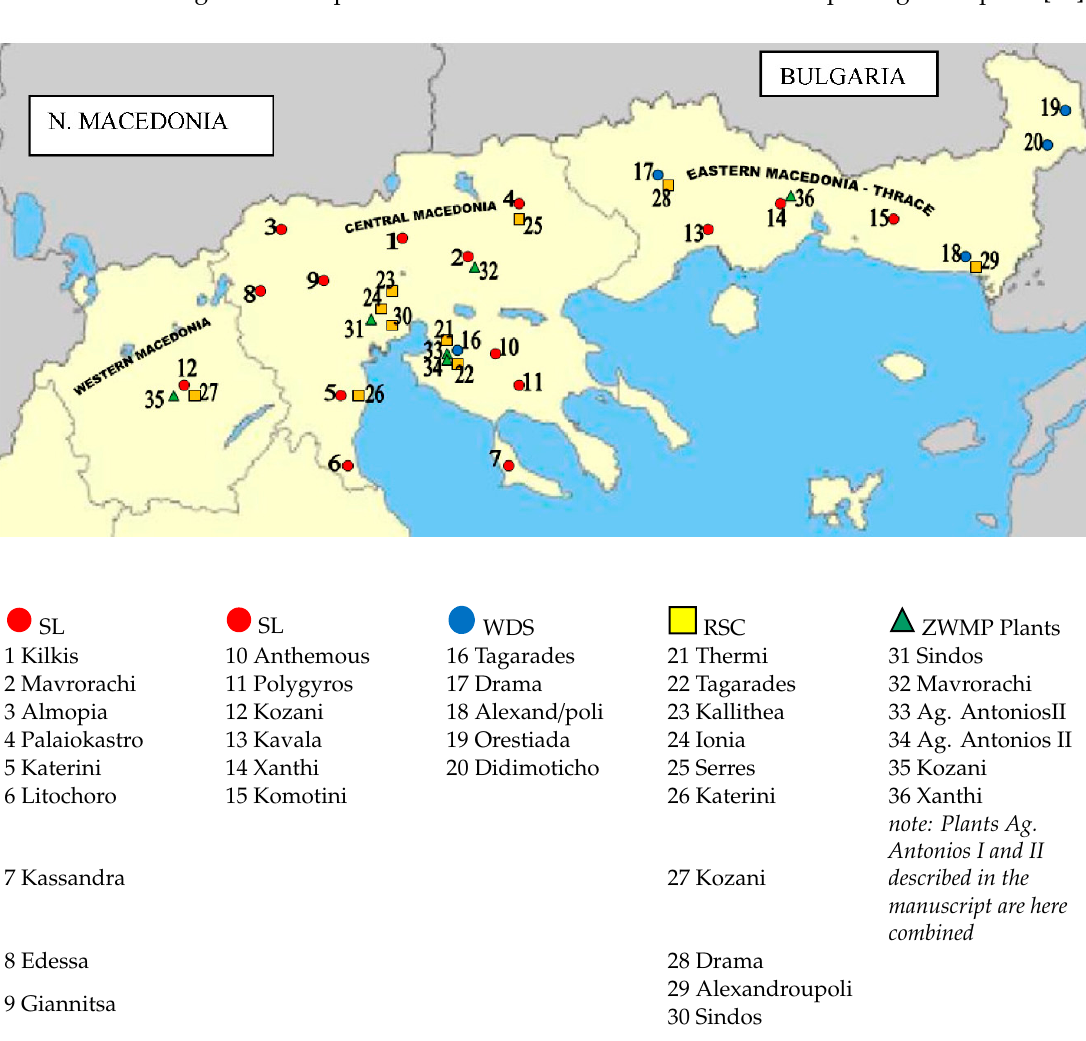
Figure 1. Proposed distribution of sanitary landfills (SL), waste disposal sites (WDS), recyclable sorting centers (RSC) and zero-waste mortar production (ZWMP) plants in Northern Greece.